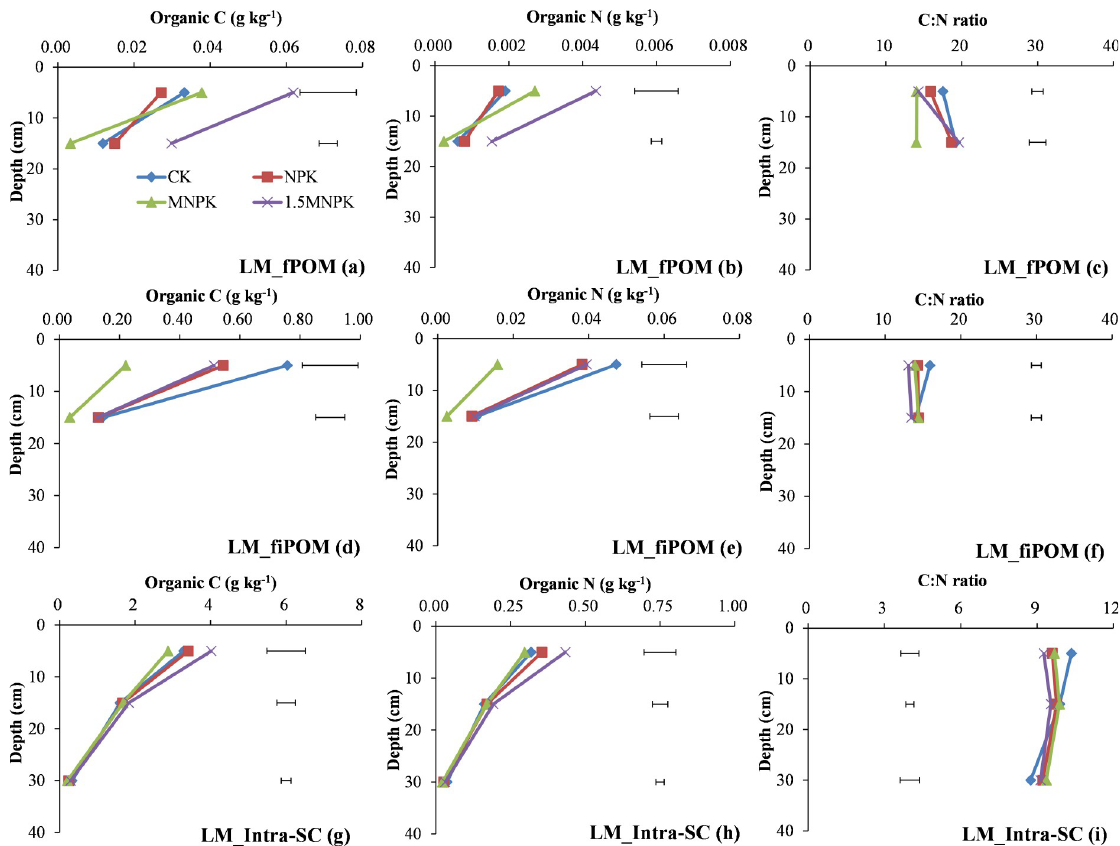
Fig 5. Change in organic C and N concentrations and their C/N ratios in microaggregates within large macroaggregate fractions of control (CK), chemical fertilizer (NPK), and combined manure and chemical fertilizer (MNPK, 1.5MNPK) treatments in the top 40 cm of the soil profile. Values at each soil depth are the mean of three replicates. The horizontal lines denote the least significant difference values at the 0.05 level (LSD0.05) among different treatments at each soil depth. Symbols of aggregate fractions: see Fig 1